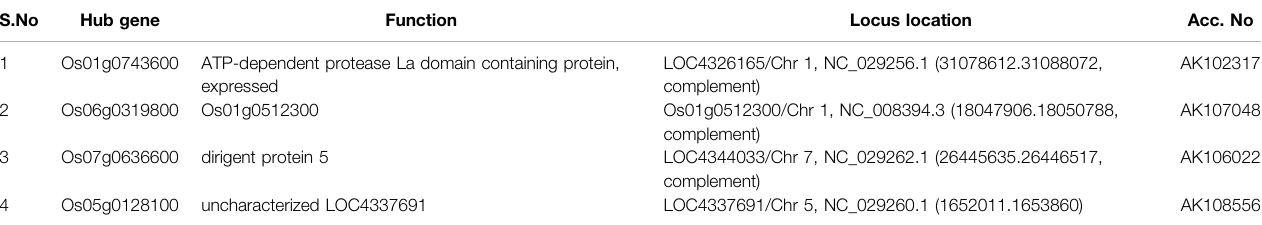
TABLE 3 | Identi fi ed hub genes with respect to their level of connectivity in the brown module.